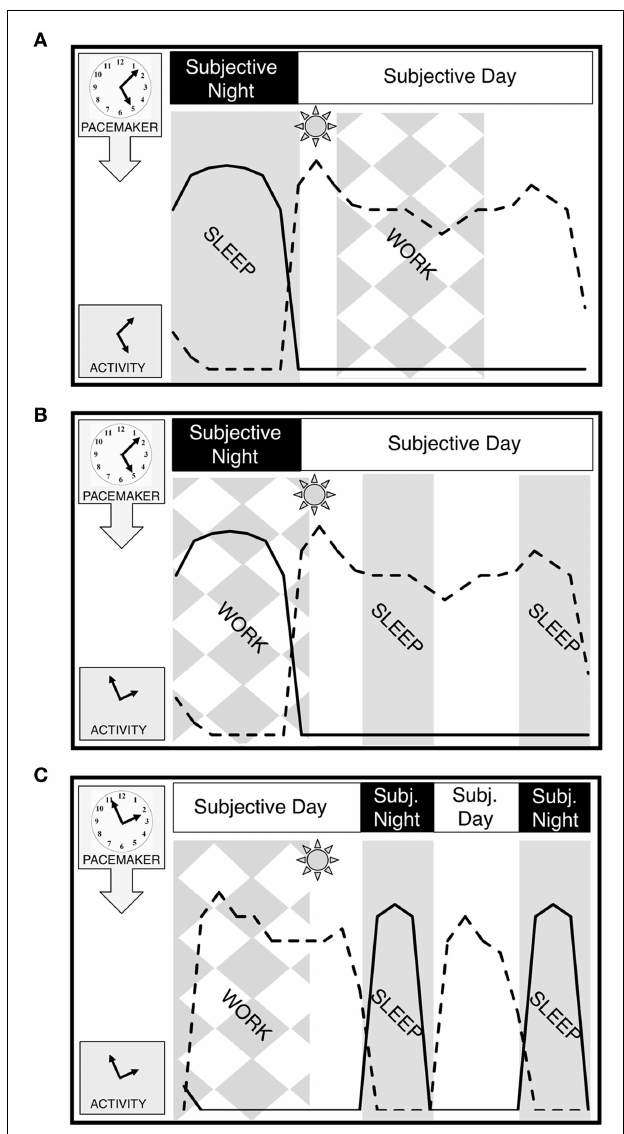
FIGURE 1 | Entrainment and dysrhythmia. (A) Normal entrainment with day work. Sleep coincides with subjective night when melatonin is elevated (solid line) and alertness is low.Work occurs in subjective day when alertness (dashed line) is elevated and melatonin is basal. Each panel begins at midnight of the environmental day.The pacemaker is represented as a clock, while activity, an output of the pacemaker, is represented as the hands of a clock. (B) Dysrhythmia in shift-work.Work is scheduled to coincide with an unaltered subjective night when melatonin is